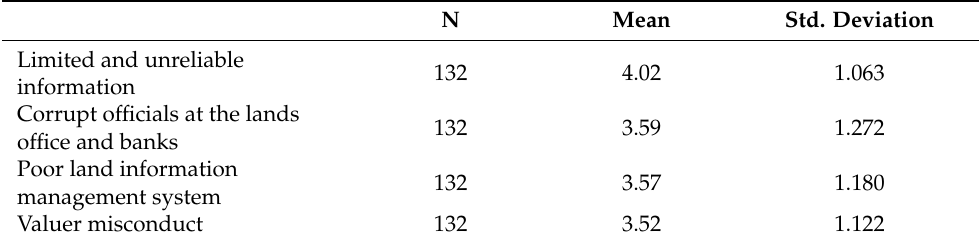
Table 14. Causes of valuation problems in